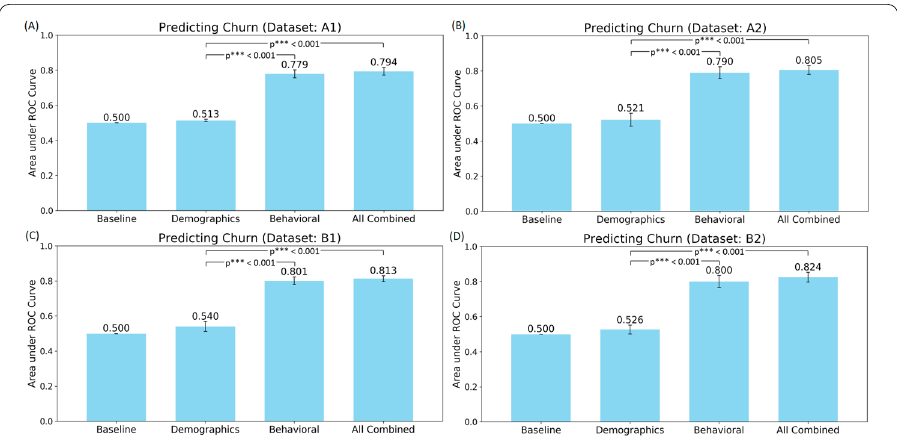
Figure 2 Area under ROC curve metric comparison of demographic features, STC features, and the combination of both feature sets for each of the data set versions. The comparison is performed for the label inac-full . The length of the error bar corresponds to 1.0 standard deviation. p ∗ ∗∗ denotes the significance level with p value smaller than